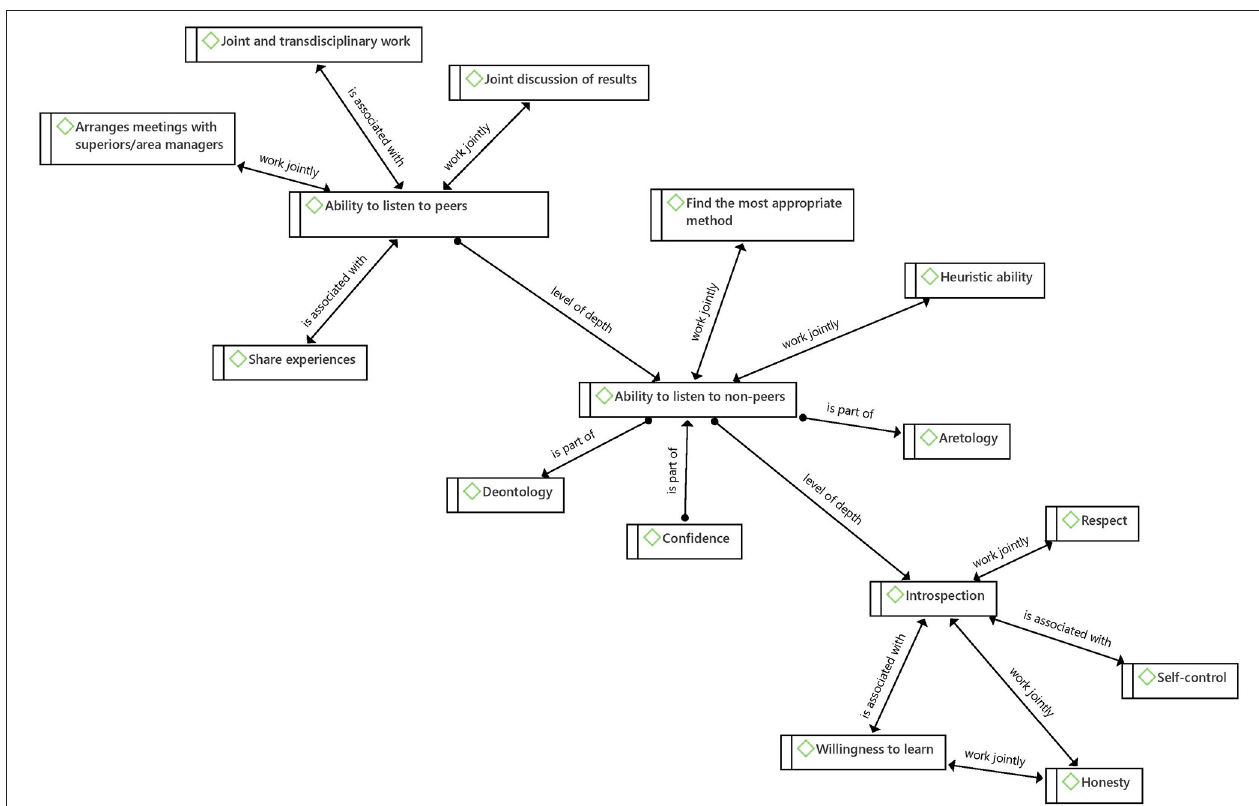
FIGURE 11 | Levels of depth in